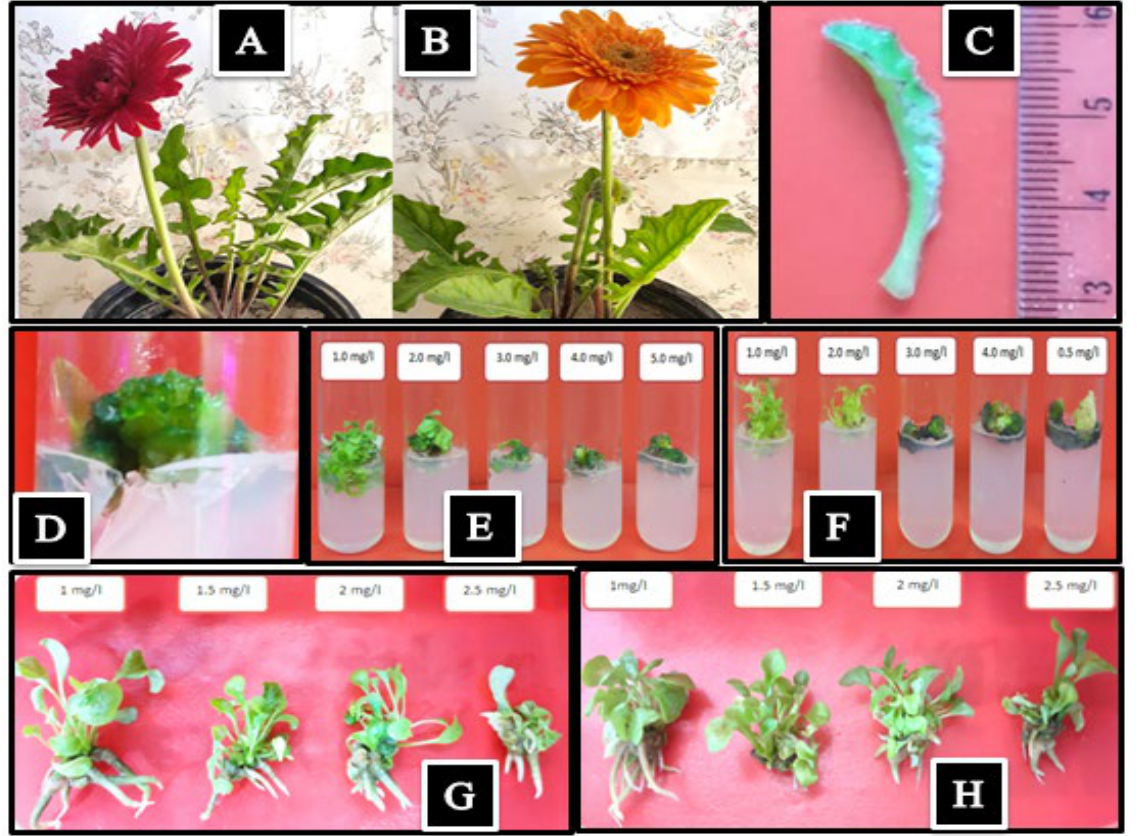
Figure 1. Adventitious shoot proliferation from callus of Barberton daisy ( Gerbera jamesonii Bolus) young leaf